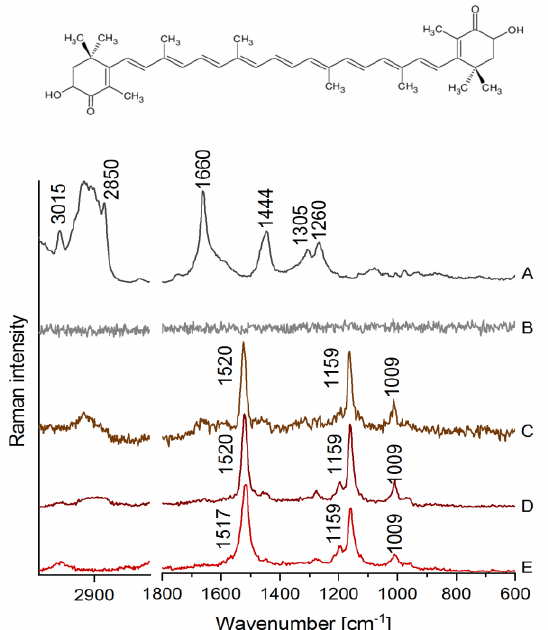
Figure 1. Raman spectra of lipids droplets (LDs) in human aortic endothelial cells (HAoEC) and (3S,3 (cid:48) S)-astaxanthin (AXT) in various environments. ( A ) A spectrum collected from an LD measured at 30 mW laser power, ( B ) a spectrum from an LD measured at 3 mW laser power, ( C ) a spectrum from an LD of the cell treated with AXT (6 h) measured at 3 mW laser power, ( D ) a spectrum of AXT dissolved in castor oil, and ( E ) a spectrum of AXT in the solid state with the AXT chemical structure on the top.